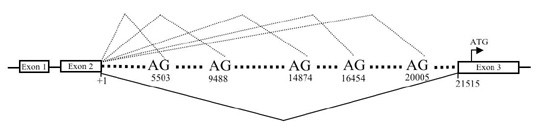
Potential alternate splicing of intron 2 of SLC26A5 containing the IVS2-2A>G variant. Alternative splice acceptor sites in intron 2 of SLC26A5 having a confidence score above 0.99 out of a maximum possible score of 1.00 are shown. Numbering of intron 2 begins at the +1 position. Dotted lines above the gene drawing show potential alternately spliced gene products. The solid line below the gene drawing shows the wild type splice donor and acceptor sites that join exon 2 to exon 3.